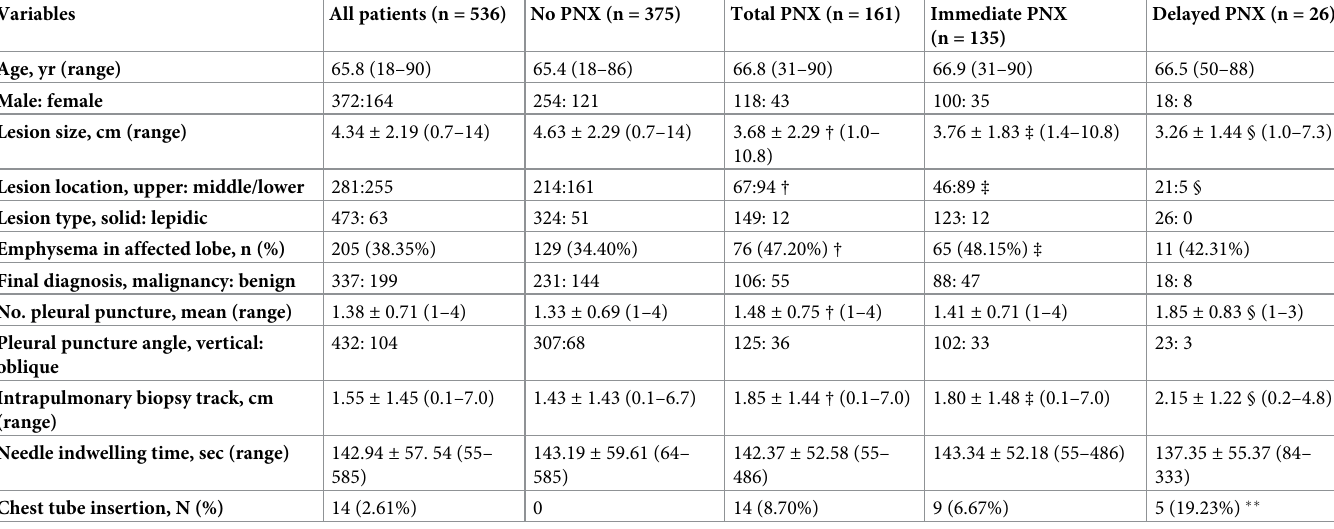
Table 1. Demographics, lesion characteristics, procedural factors, and incidence of chest tube